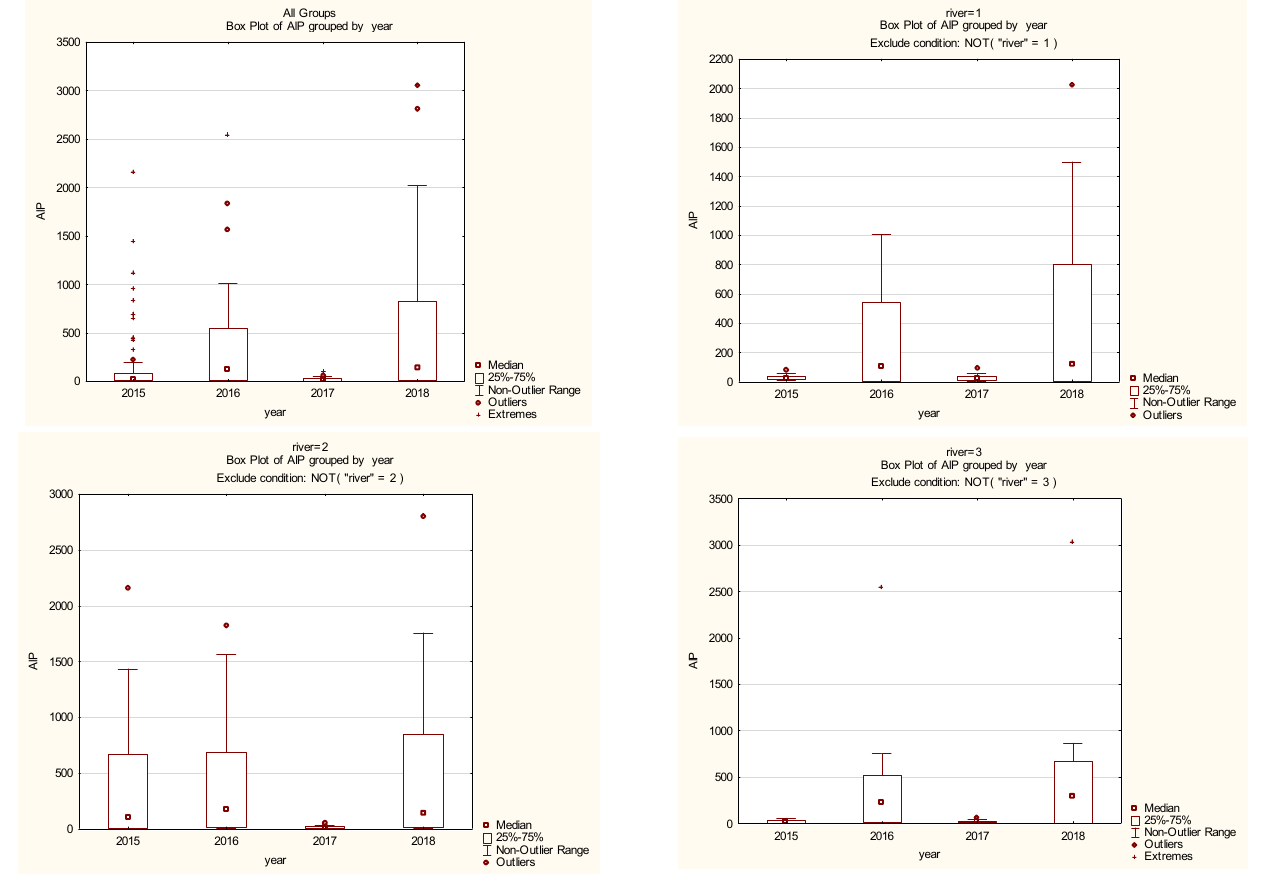
Figure 3. Al concentration in plants from rivers across 29 sites depending on year (1—Bystrzyca, 2—Nysa Szalona, 3—Strzegomka).